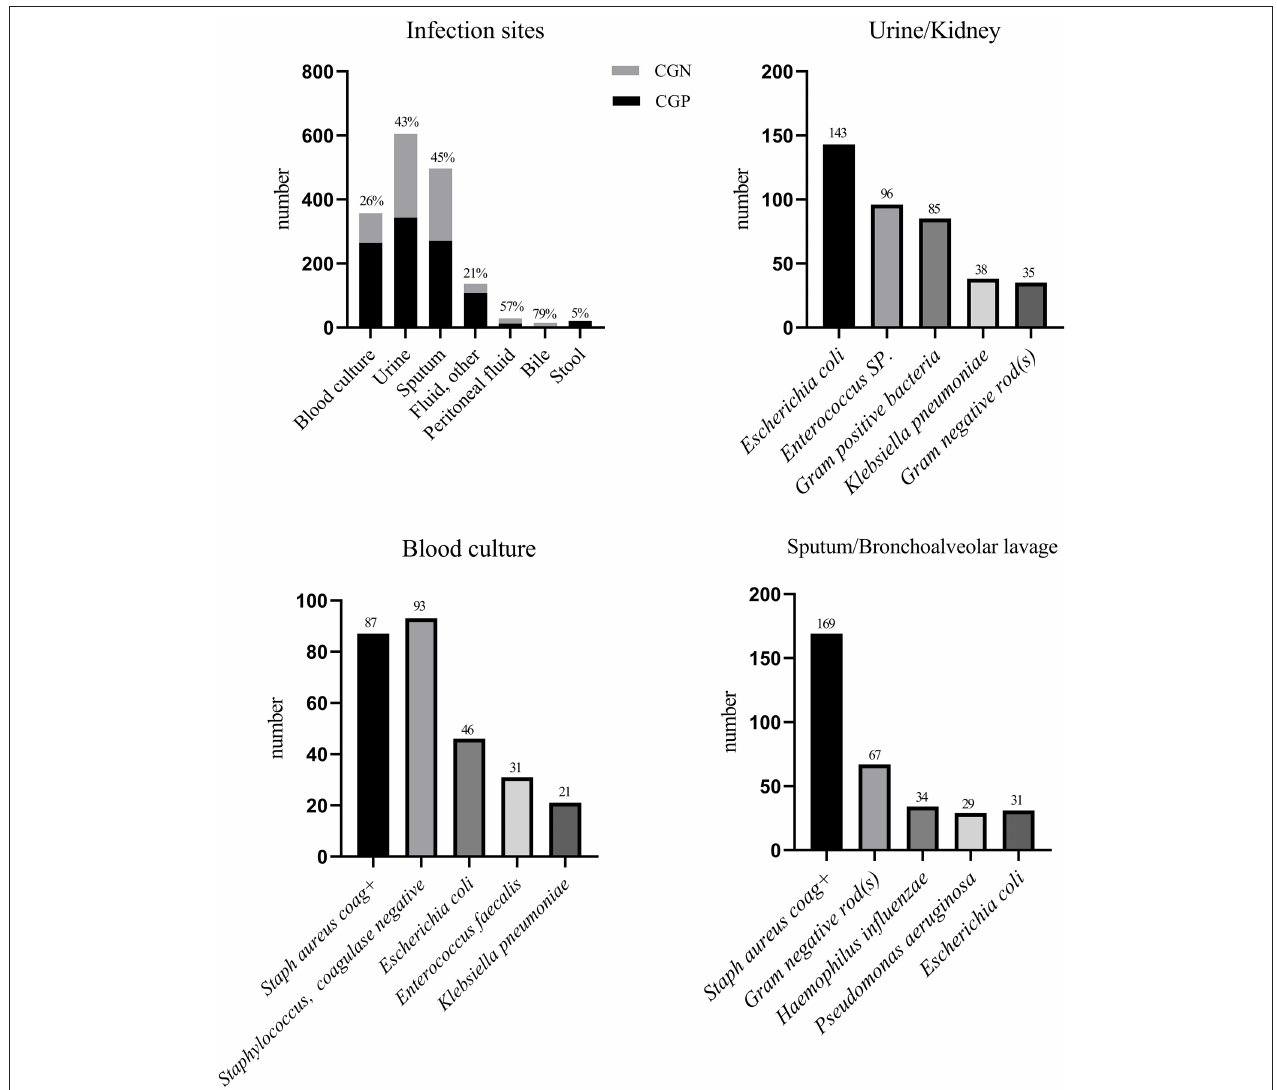
FIGURE 2 | Main sites of infection and the top five bacteria in each